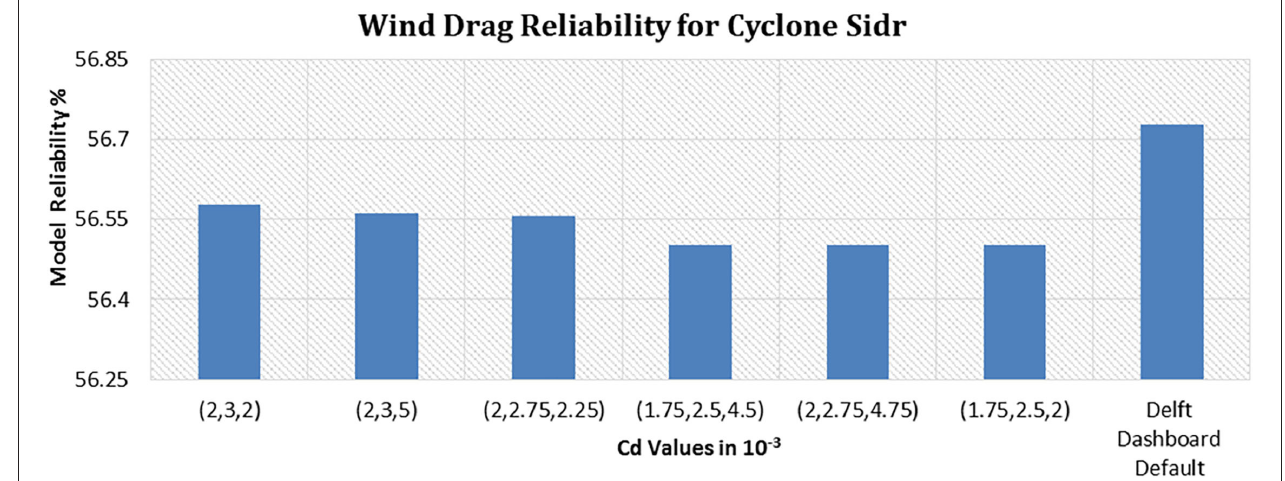
FIGURE 5 | Average model reliability due to different wind drag conditions for cyclone Sidr.